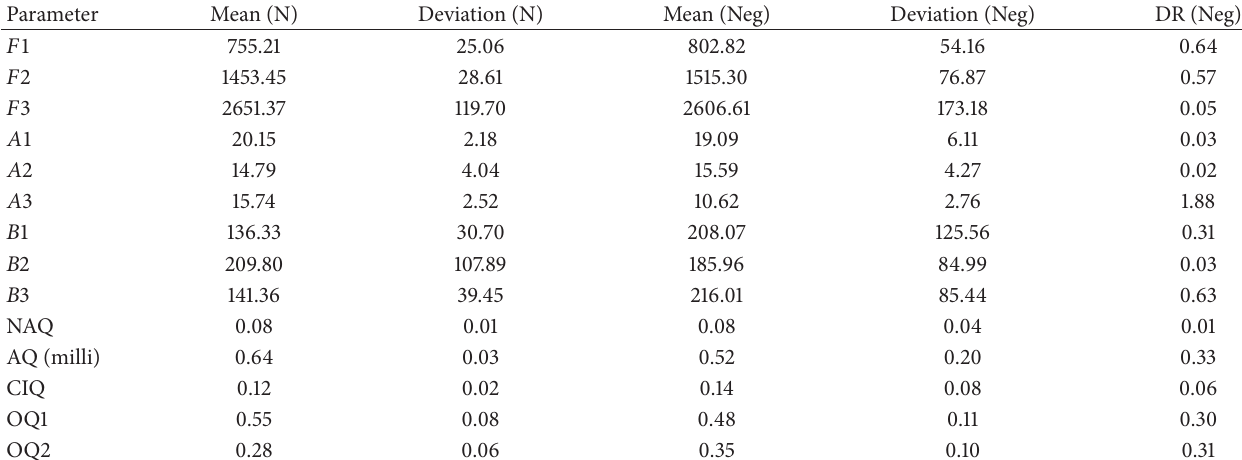
pitch values in case of speaker DC. In 6 out of those